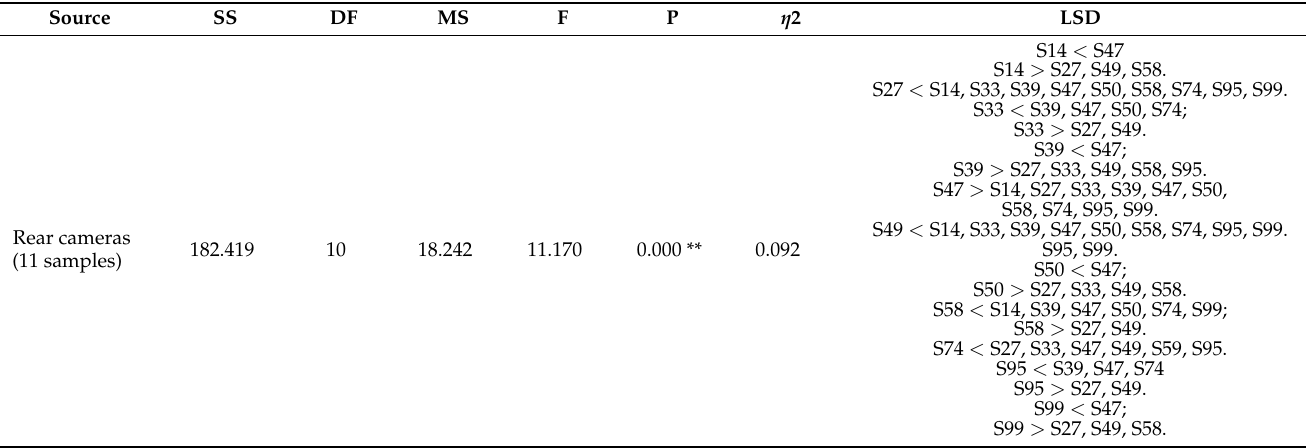
Table 12. The results of the general linear